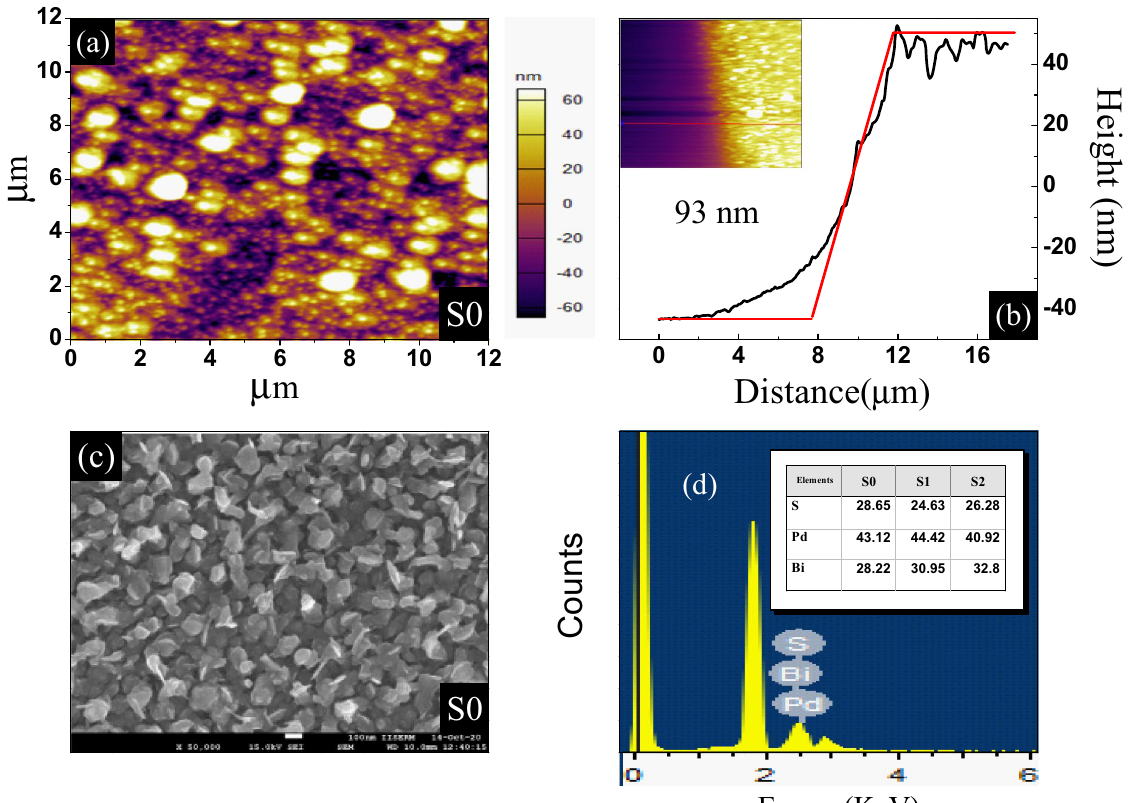
Figure 2. ( a ) Atomic Force Microscope topography image of the surface of the S0 PBS thin film. (b ) The height 93 nm. ( c ) An SEM image of the surface of the S0 film. ( d ) Results profile across the S0 film with a thickness ≈ of the EDS spectroscopy on S0 showing the presence of Pd, Bi, and S in stoichiometric amounts in the film.